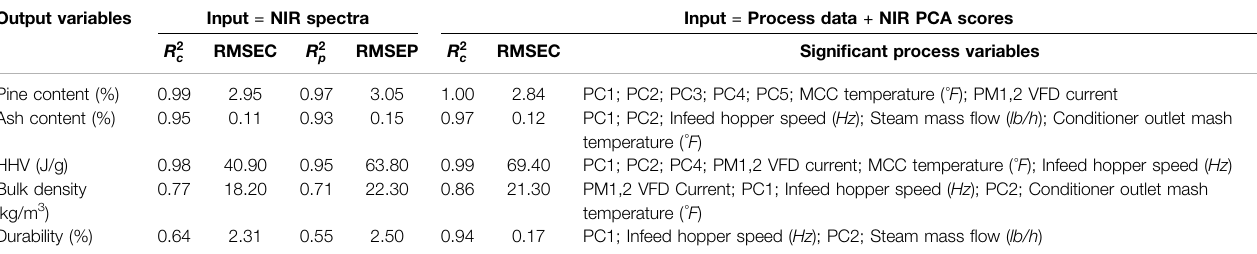
TABLE 4 | Performance of PLSR models for predicting pellet properties based on NIR PCA scores (in 950 – 1,650 nm region) and pelleting process